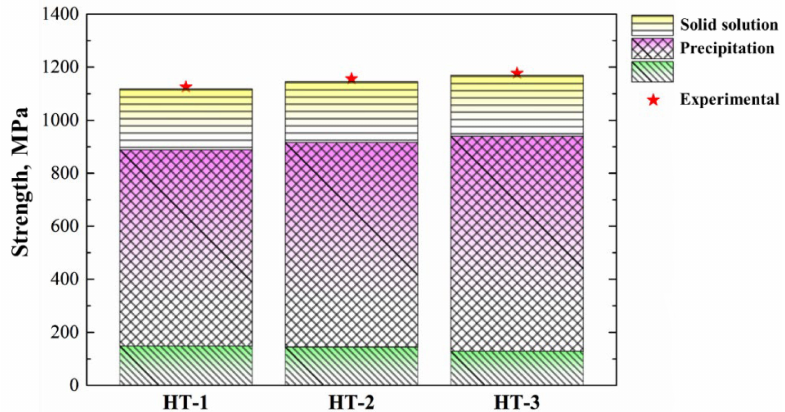
Figure 12. The strength calculated to be contributed by the grain boundary, solid solution strengthen- ing and precipitation strengthening compared to the experimental results for the yield strength at ambient